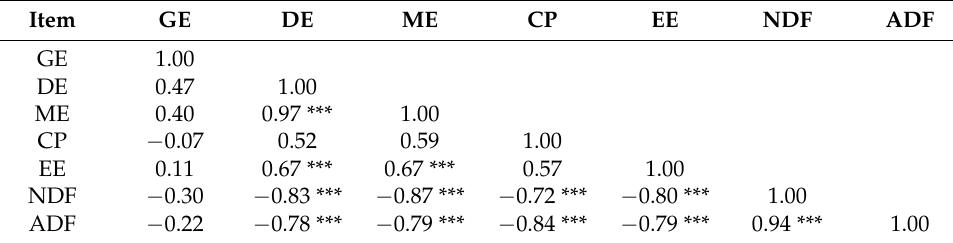
Table 4. Correlation coefficients among the chemical compositions and energy in the